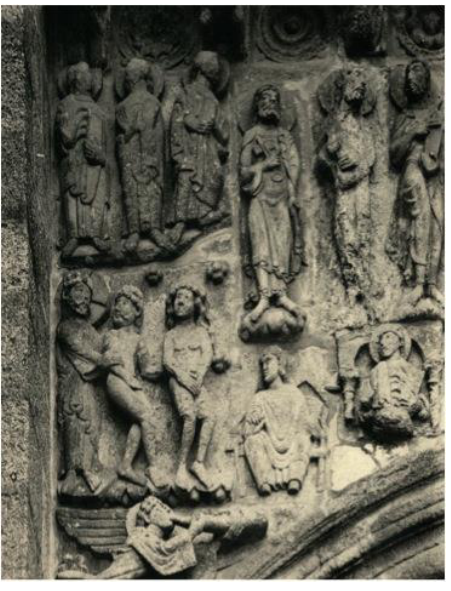
Contemporaneity: Historical Presence in Visual Culture http://contemporaneity.pitt.edu Vol 5, No 1 “Agency in Motion” (2016 ) | ISSN 2155-1162 (online) | DOI 10.5195/contemp.2016.149